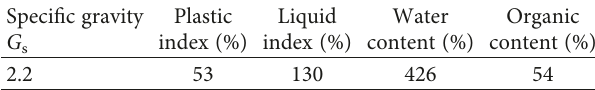
Table 1: Basic properties of sewage sludge. Specific